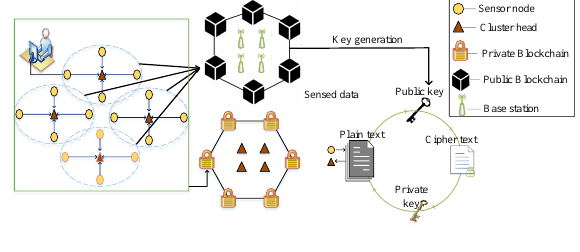
Figure 1. The proposed system